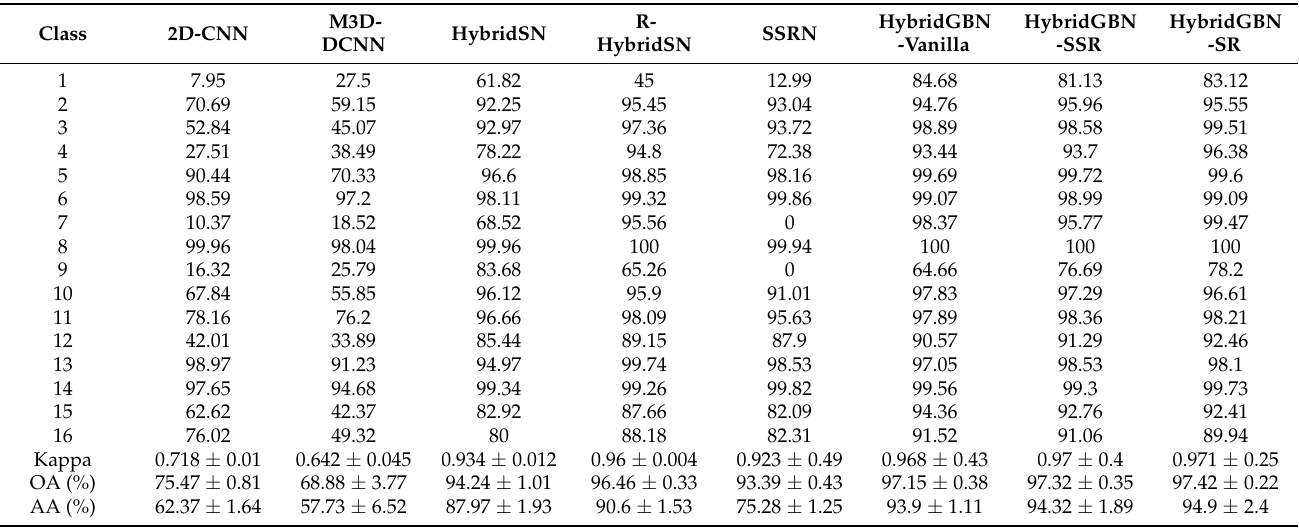
Table 4. The Kappa, OA, and AA results in a percentage of the compared models at 5% training sample data over IP dataset.